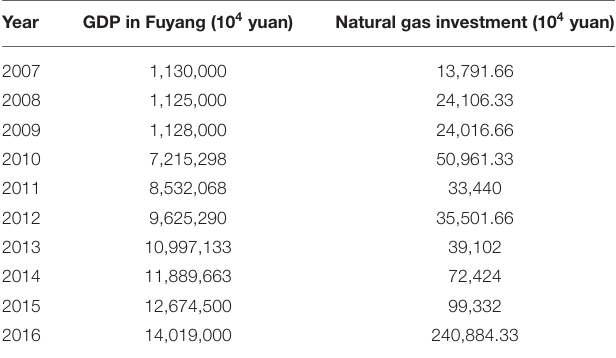
TABLE 3 | Overview of natural gas investment in Fuyang City from 2007 to 2016.